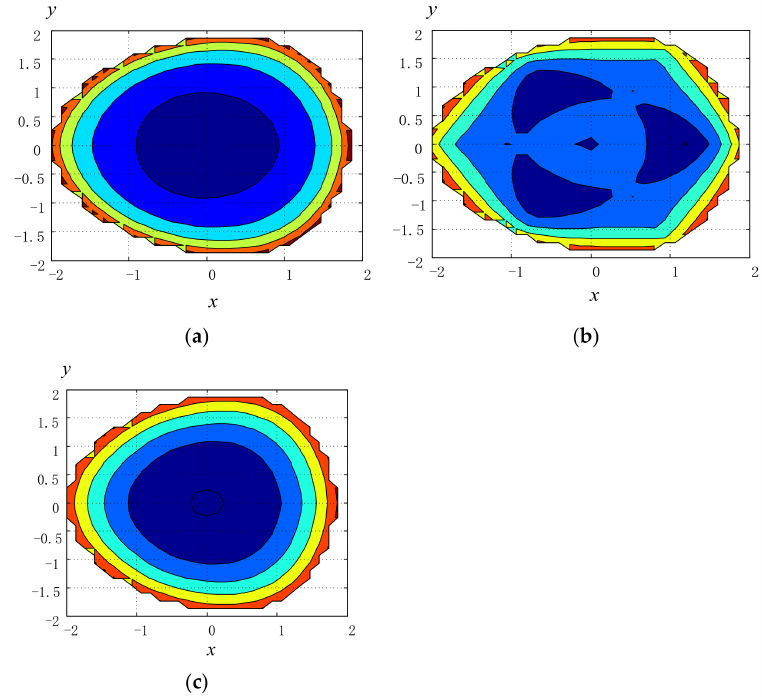
Figure 9. Contours of κ and of the maximum ITA and CTA in bounded workspace. ( a ) Contours of κ